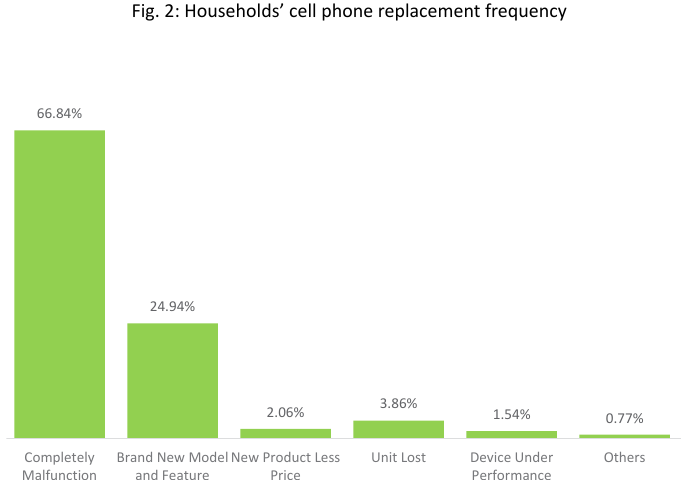
Fig. 3: Households’ cell phone reason for Fig 3: Households’ cell phone reason for replacement